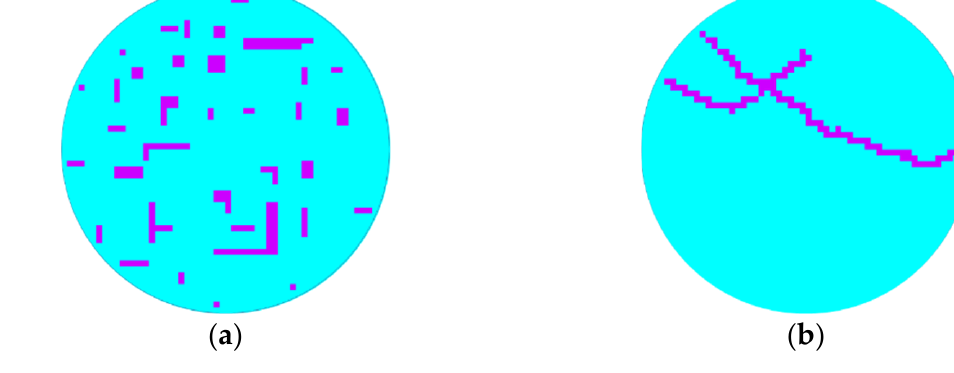
Figure 3. ( a ) Local defect pa(cid:308)ern; ( b ) global defect pa(cid:308)ern. For wafer pa(cid:308)erns with a large area, low feature size, low density, and low integra-